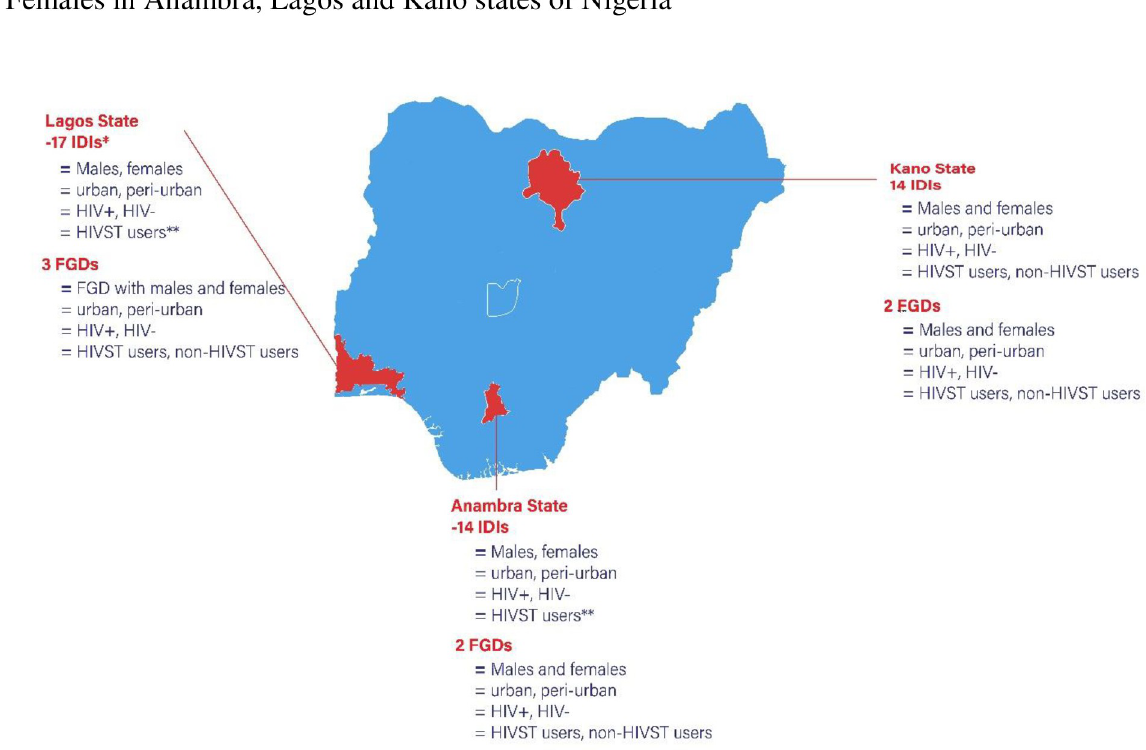
Fig 1. showing the demographic characteristic of FGDs and IDIs with sexually active males and females in Anambra, Lagos and Kano states of